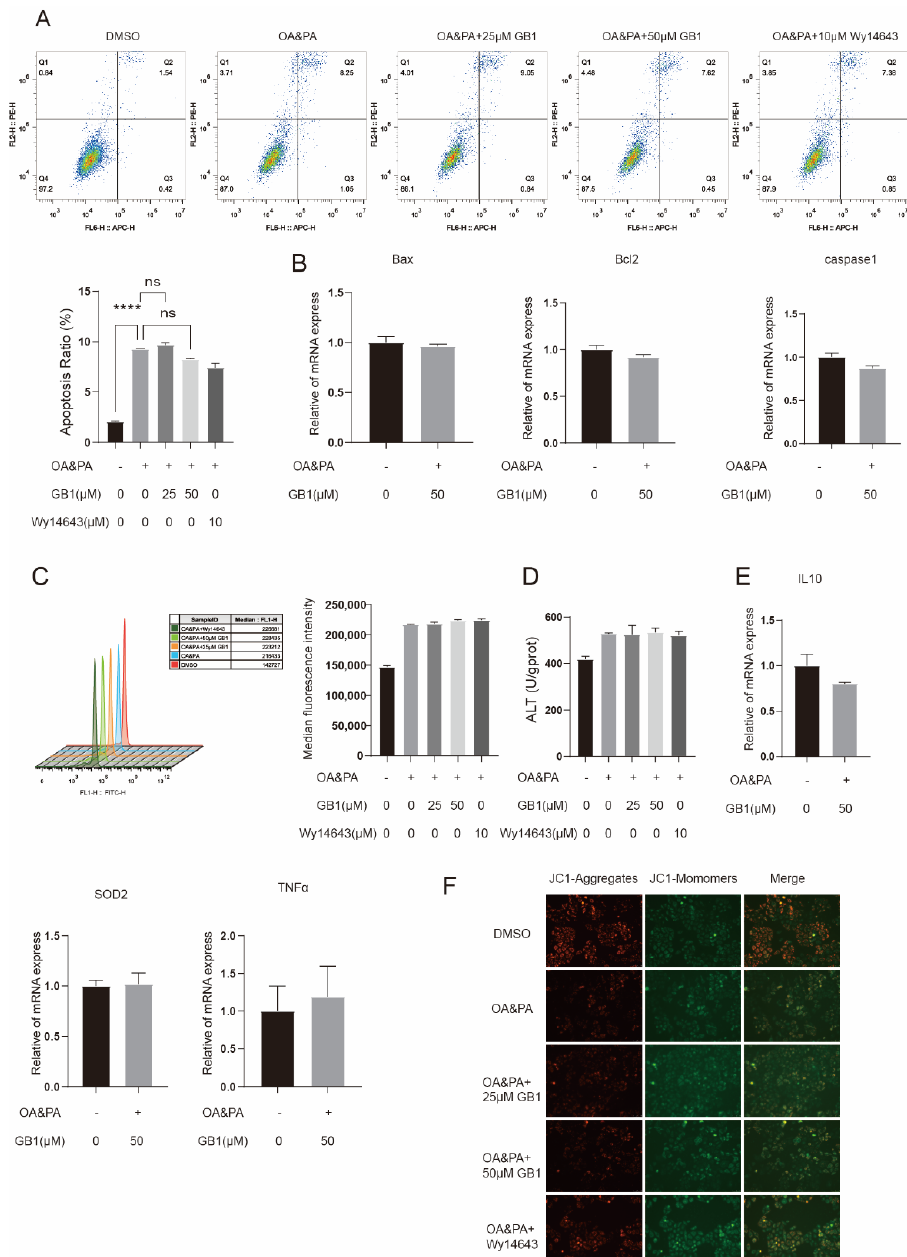
Figure 6. GB1 fails to improve inflammation and apoptosis in PPAR α -deficient cells. ROS level ( A ) and apoptosis ( C ) in PPAR α -deficient cells did not change after GB1 treatment. GB1 failed to alter the levels of inflammatory genes ( E ), apoptosis-related genes ( B ), ALT ( D ), and MMP ( F ) in PPAR α - deficient cells. All data were presented as mean ± SEM of three independent experiments.****, p < 0.001; ns, not significant.